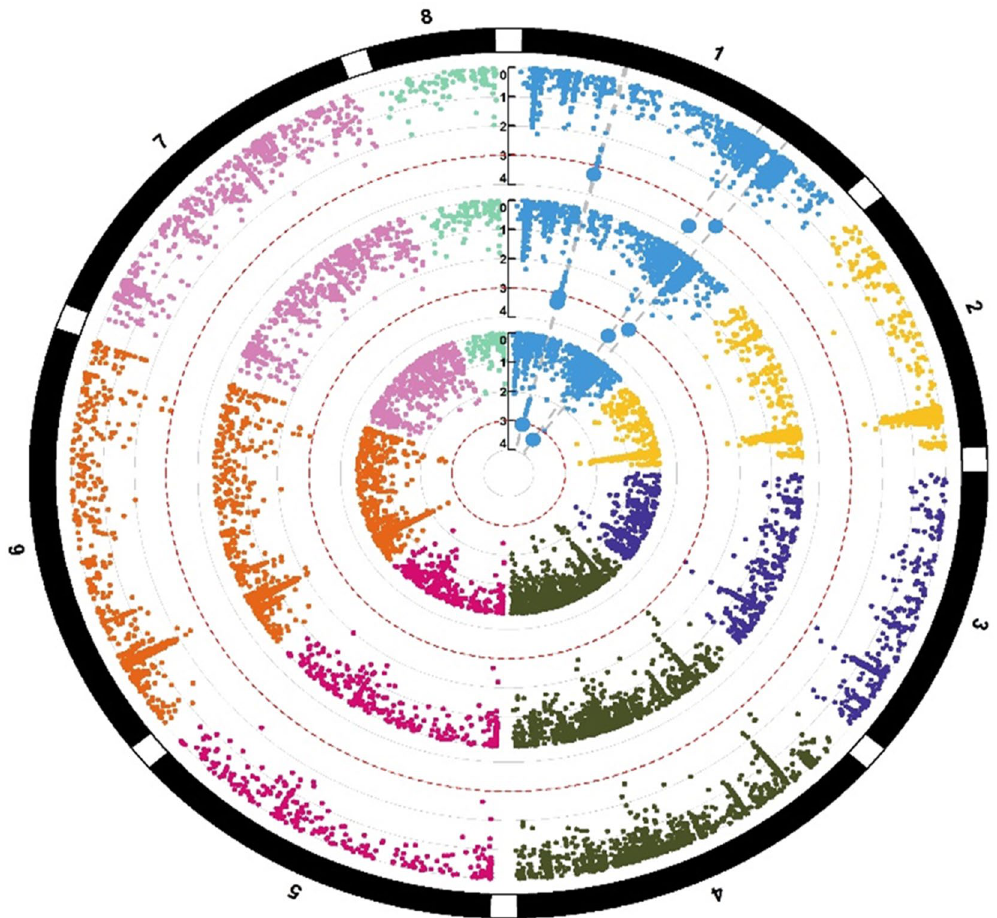
Figure 4. Circular Manhattan plots of showing marker-trait associations (MTAs) for seed Cu concentrations. The eight different colors represent 8 different chickpea chromosomes. The three concentric circles (each having 8 colors) shows MTAs identified for seed Cu concentrations in two environments and data pooled over environments.